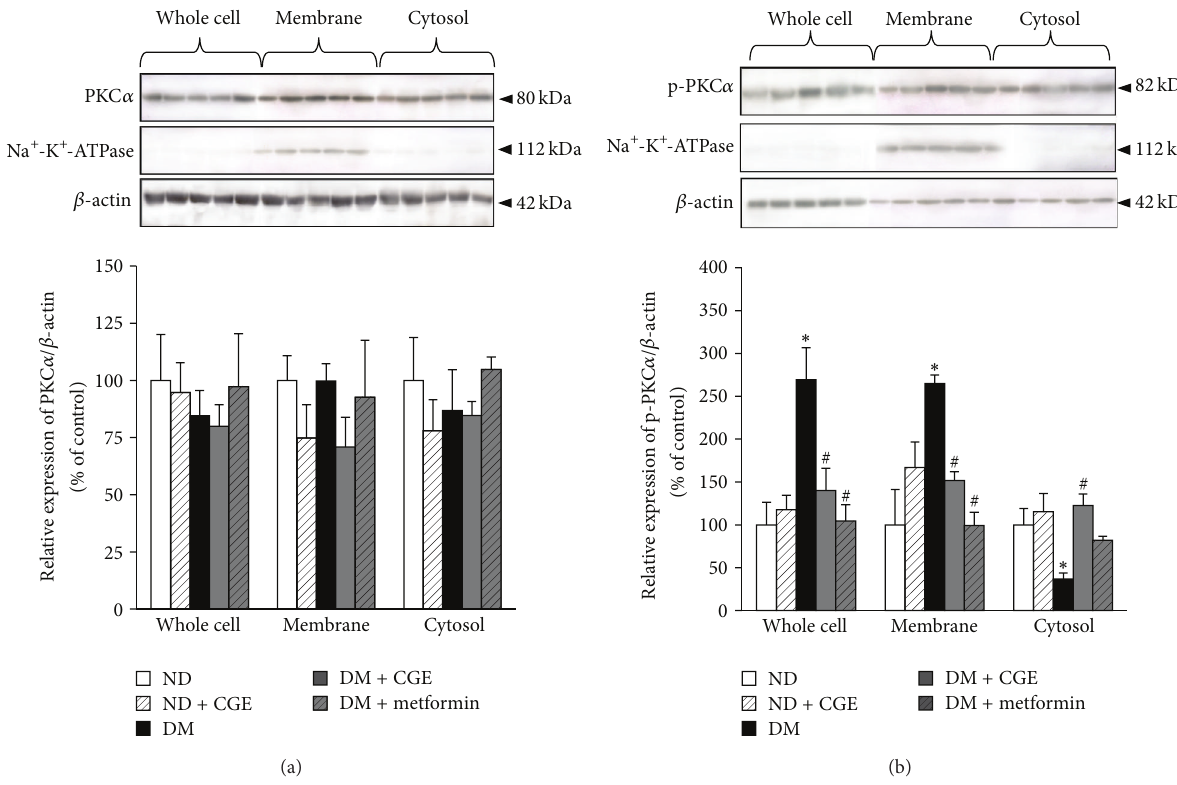
Figure 5: Effects of Cladophora glomerata extract on PKC 𝛼 expression, activation, and translocation in renal cortical tissues. Whole cell lysate, cytosolic, and nuclei fractions were extracted from rat renal cortical tissues. The samples were then separated using electrophoresis and western blotting. (a) Anti-PKC 𝛼 and (b) p-PKC 𝛼 antibodies were subsequently detected while anti-Na + -K + -ATPase and anti- 𝛽 -actin antibodies were used as a membrane marker and loading control, respectively. The data are expressed as mean ± SD and repeated from separate sets of animals ( 𝑛 = 5 ). A representative blot of PKC 𝛼 and p-PKC 𝛼 protein expressions is shown in top panel ((a) and (b)) and quantification of relative protein expression in each fraction is presented in bottom panel ((a) and (b)).